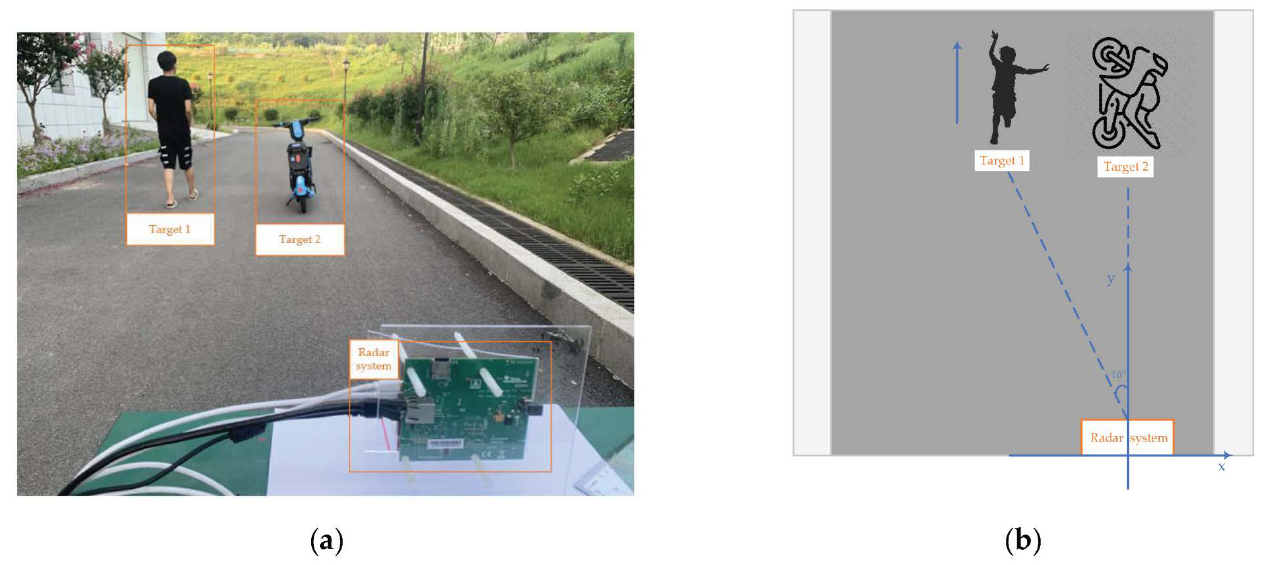
Figure 15. Outdoor experimental scenes. ( a ) is the outside environment. ( b ) is the model diagram of